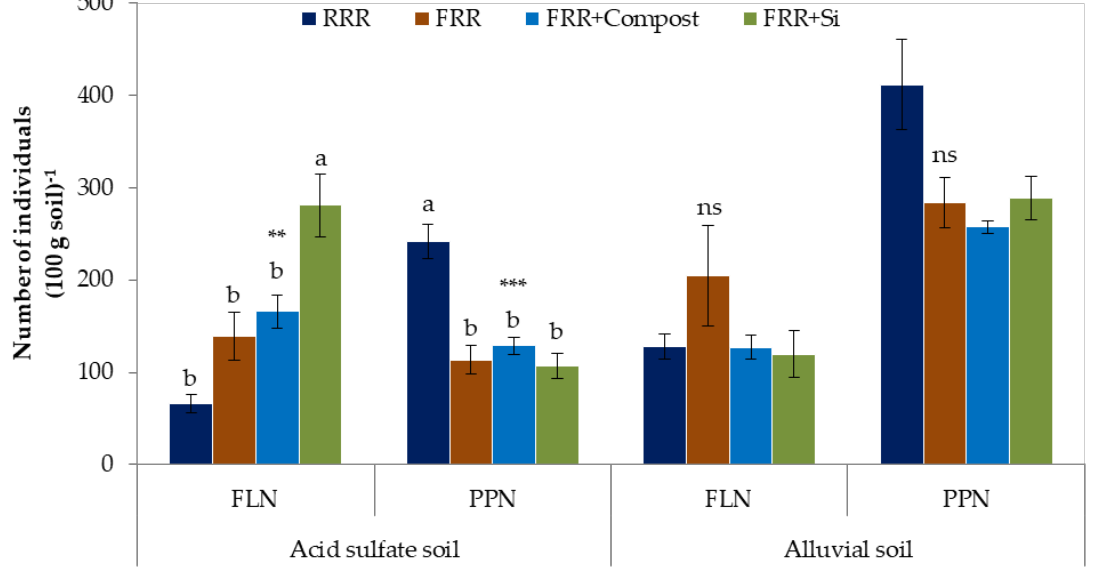
Figure 2. Abundance (mean ± standard error, n = 4) of free–living nematode (FLN) and plant–parasitic nematode (PPN) among treatments in different soil types, the acid sulfate soil in Ben Tre province and the alluvial soil in Kien Giang province, Vietnam. Different letters indicate a significant difference in abundance of FLN and PPN among treatments at ** p < 0.01, *** p < 0.001, ns, not significant. RRR, triple–rice system; FRR, fallow and double–rice; FRR + Compost, fallow and double–rice with 3 Mg ha –1 sugarcane filter cake compost; FRR + Si, fallow and double–rice with 100 kg ha –1 silicate fertilizer.